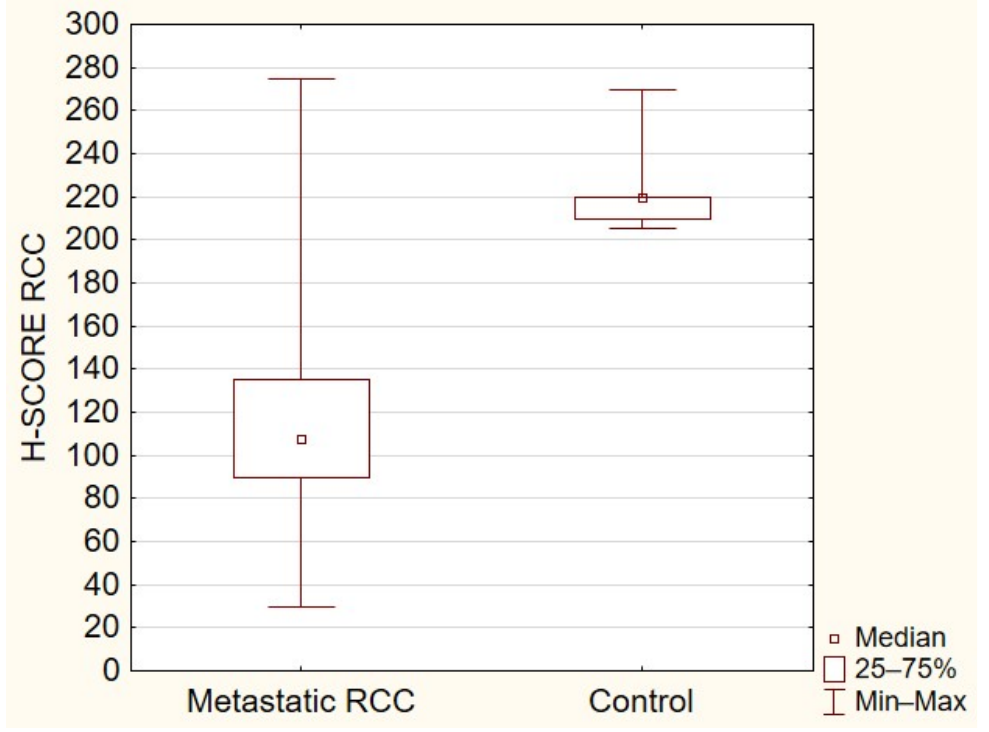
Figure 2. TOLLIP expression in metastatic RCC and control ( p < 0.05).